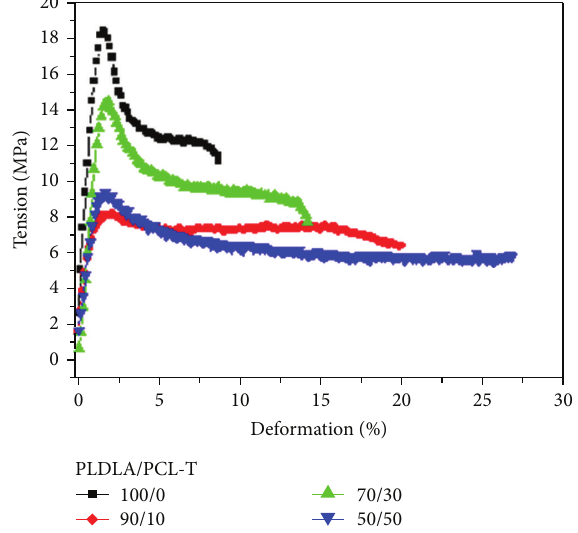
Figure 6: Tension versus deformation curves for PLDLA/PCL-T membranes. Standard deviation bars have been omitted for